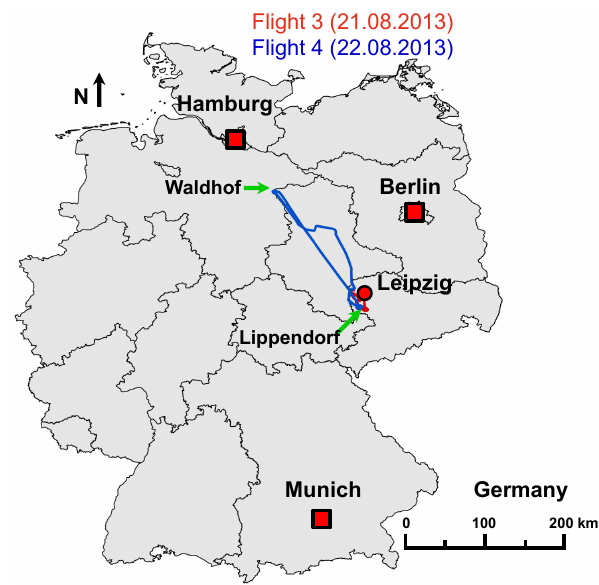
Figure 2. Flight tracks of the ETMEP-2 measurement flights, num- bers 3 and 4, over central and northern Germany. The flights were made from the Leipzig